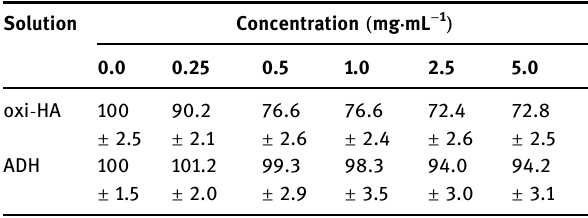
Table 1: Cell cytotoxicity of BALB/c 3T3 ( % ) exposed to oxi - HA acid and ADH solution; data are reported as mean ± SD for